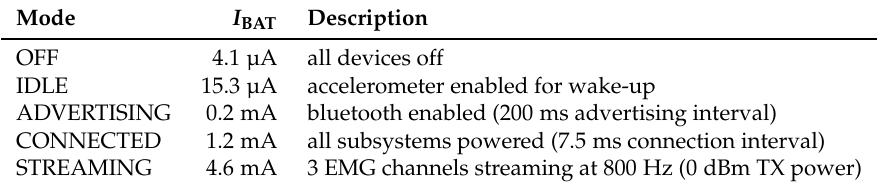
Table 4. Current consumption at V BAT = 4.0 V and V DD = 1.8